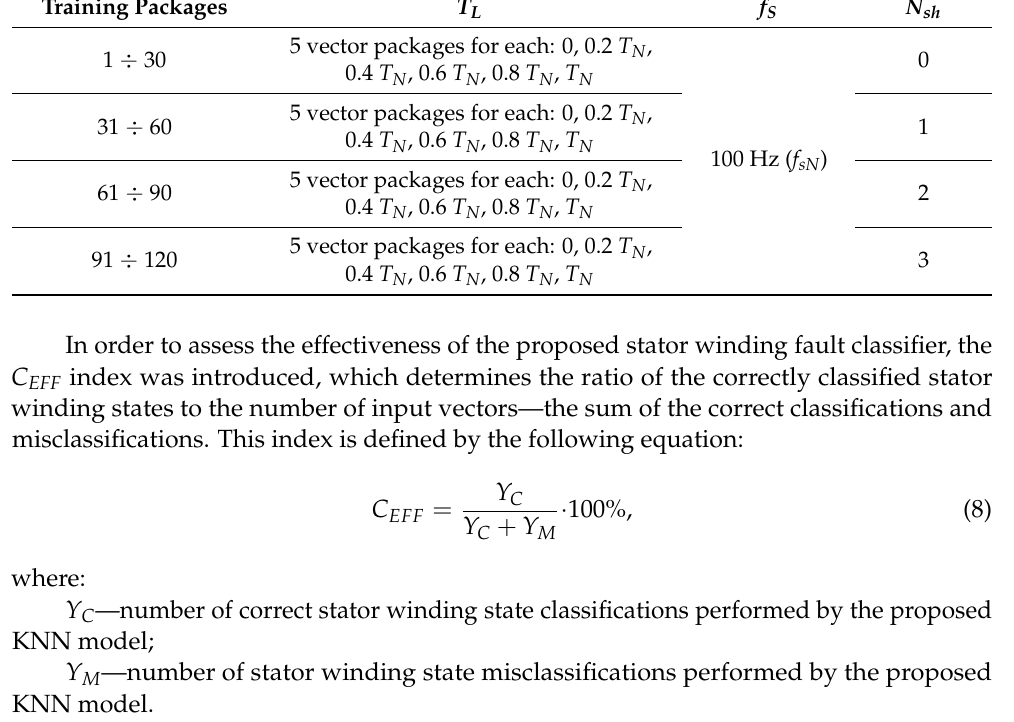
Figure 11. The impact of the K-nearest neighbors value and distance metric on the KNN classifier training